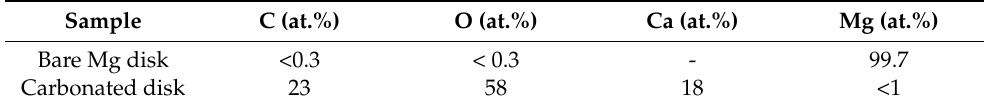
Table 1. EDS compositional analysis after immersion treatment for 1 h.